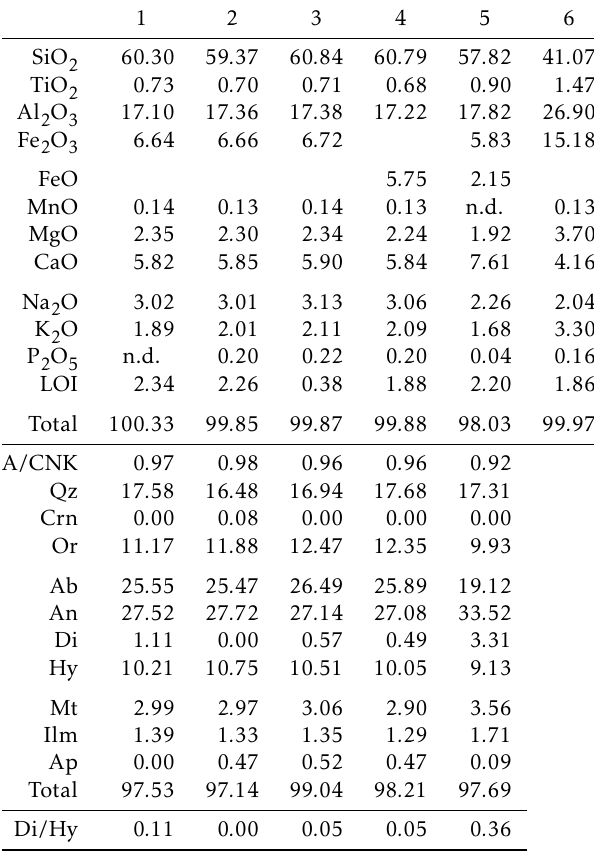
Table 1: Whole-rock composition of the andesite of Breziny (analyses 1–5) and a garnet-bearing metased- imentary enclave (analysis